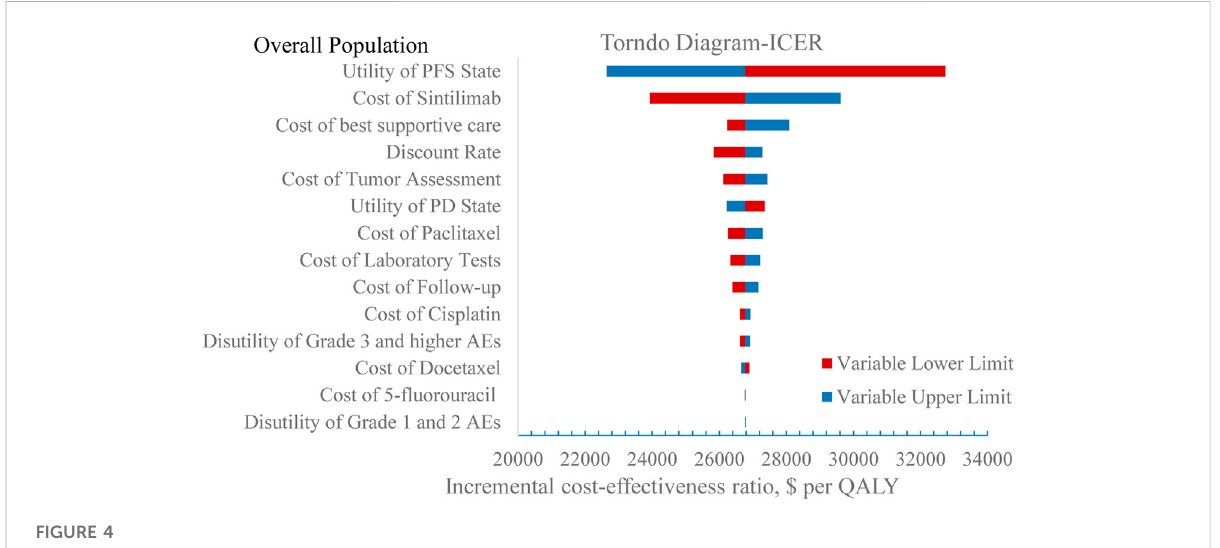
FIGURE 4 One-way sensitivity analysis in overall population.